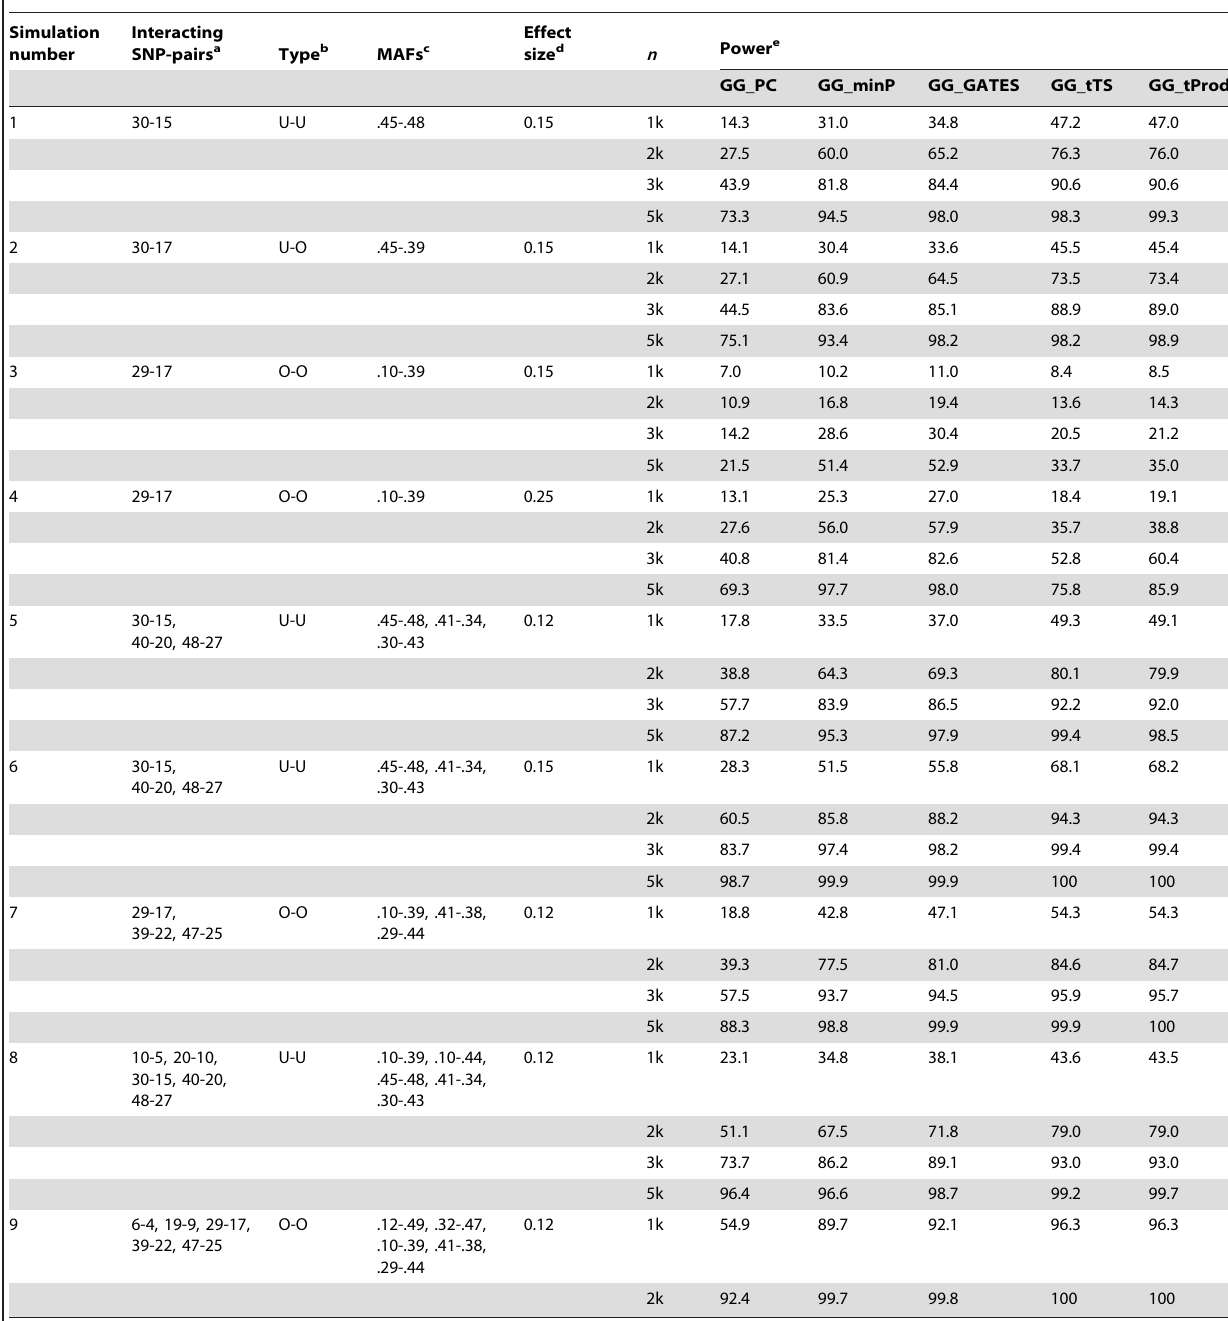
Table 2. Empirical, simulation-based statistical power of GGG tests.